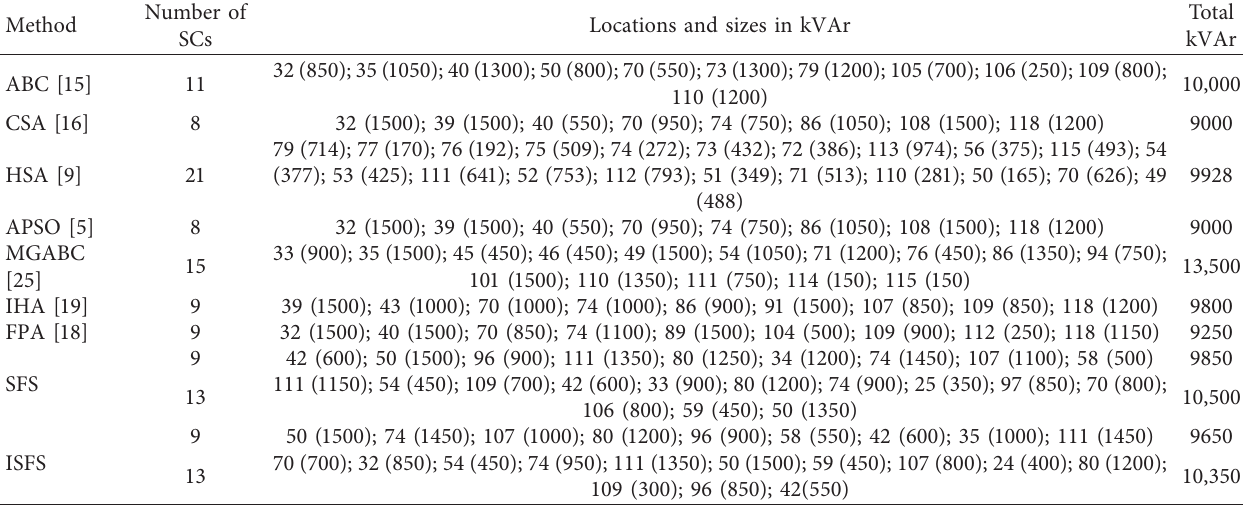
Table 7: Optimal locations and sizes of SCs for 119-bus network at 100% loading in scenario 1 by different methods.